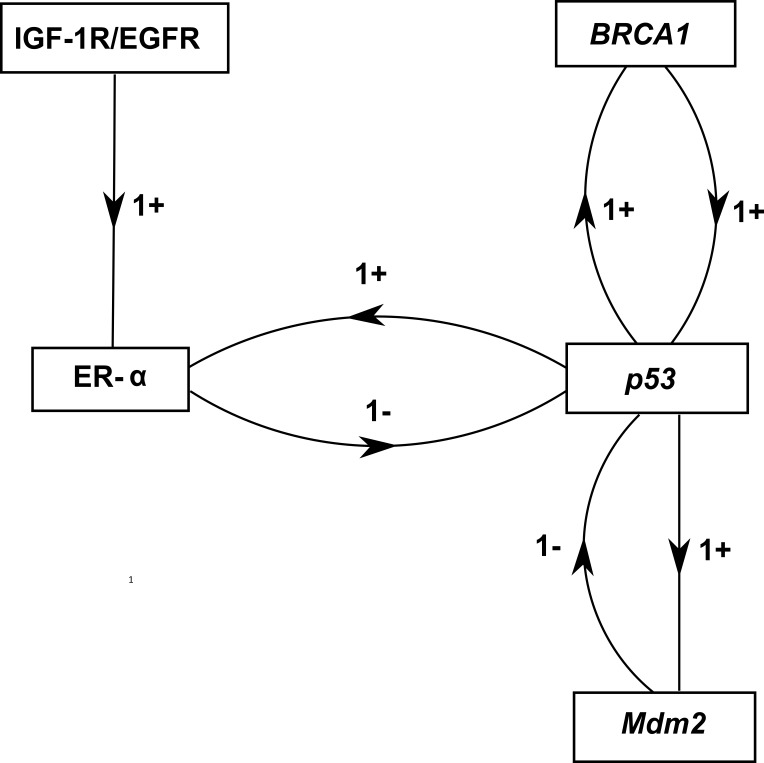
ER-α associated BRN.Activation is indicated by a positive (+) sign while negative (−) sign indicate inhibition. The direction of activation/inhibition is represented by arrows. The levels of entities are set according to Definition 2. The formal description of the BRN is \documentclass[12pt]{minimal}
\usepackage{amsmath}
\usepackage{wasysym} 
\usepackage{amsfonts} 
\usepackage{amssymb} 
\usepackage{amsbsy}
\usepackage{upgreek}
\usepackage{mathrsfs}
\setlength{\oddsidemargin}{-69pt}
\begin{document}
}{}$N=\{IGF-1R/EGFR,ER-\alpha ,BRCA1,p53,Mdm2\}$\end{document}N=IGF−1R∕EGFR,ER−α,BRCA1,p53,Mdm2; \documentclass[12pt]{minimal}
\usepackage{amsmath}
\usepackage{wasysym} 
\usepackage{amsfonts} 
\usepackage{amssymb} 
\usepackage{amsbsy}
\usepackage{upgreek}
\usepackage{mathrsfs}
\setlength{\oddsidemargin}{-69pt}
\begin{document}
}{}$ED=\{(IGF-1R/EGFR\rightarrow ER-\alpha ),(ER-\alpha \rightarrow p53),(p53\rightarrow Mdm2),(p53\rightarrow BRCA1),(BRCA1\rightarrow p53),(Mdm2\rightarrow p53),(p53\rightarrow ER-\alpha )\}$\end{document}ED=IGF−1R∕EGFR→ER−α,ER−α→p53,p53→Mdm2,p53→BRCA1,BRCA1→p53,Mdm2→p53,p53→ER−α.